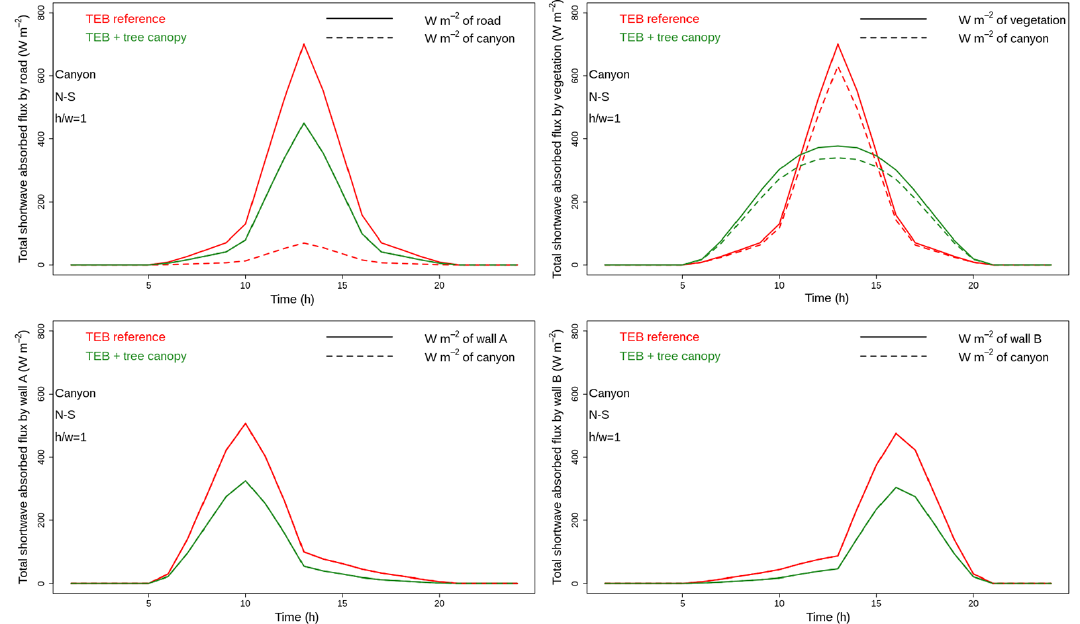
Figure 8. Comparison of the total shortwave radiation flux (Wm − 2 ) absorbed by road, walls, and tree between the reference TEB simulations without distinction between low and high vegetation, and the new version including an explicit tree canopy corresponding to configuration A within a north–south-oriented canyon with an aspect ratio of h/w = 1 during a summer day. The fluxes are expressed either in Wm − 2 of the considered surface or in Wm − 2 of